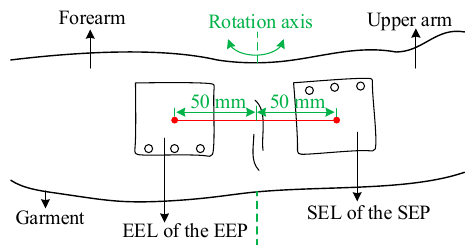
Figure 6. Schematic of installation position of the NFCAS.